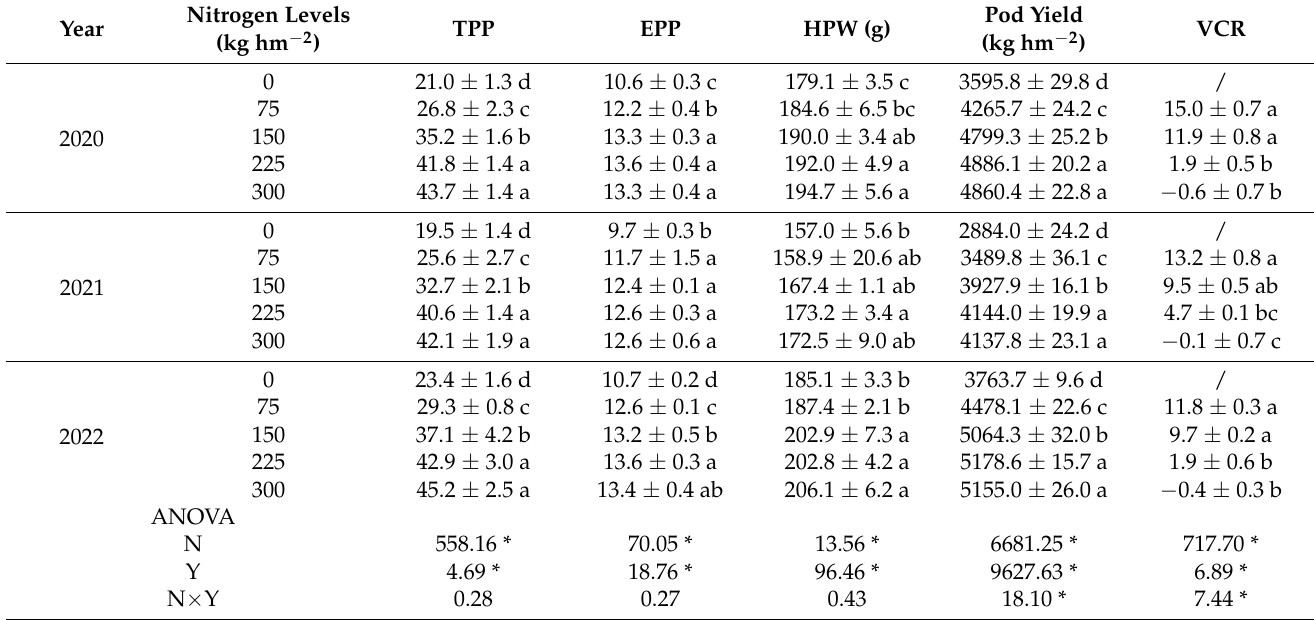
Table 3. Effects of different nitrogen levels on TPP, EPP, HPW, Pod Yield and